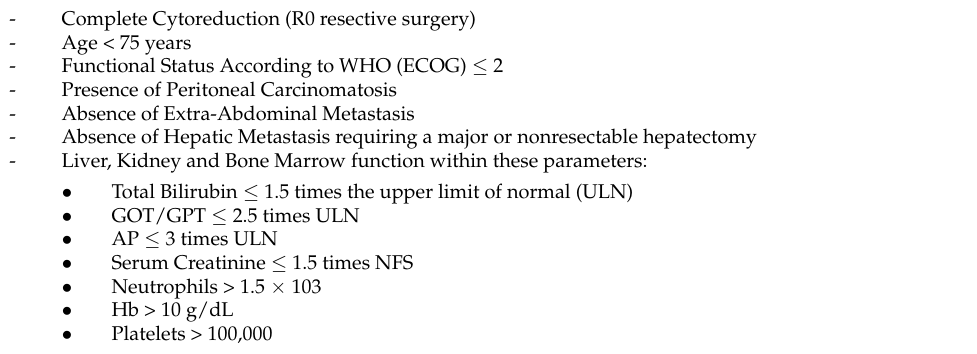
Table 3. Inclusion criteria